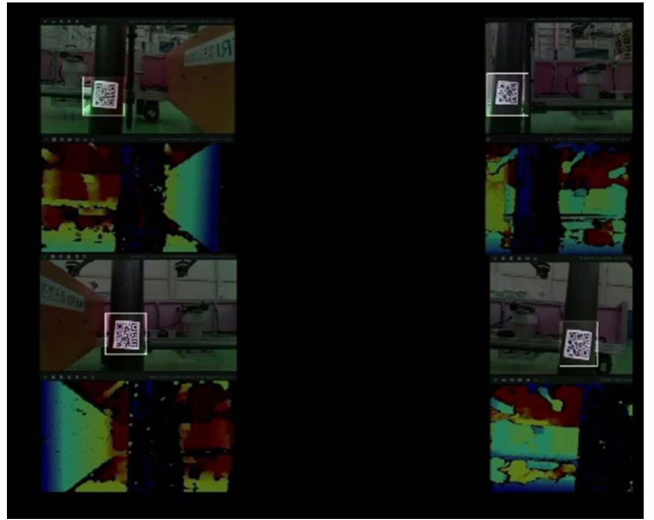
Figure 17. Camera images of the mobile station after completing the precision move (angular error: 0.03 ◦ , at a distance of 3.4